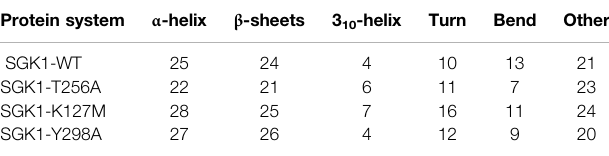
TABLE 2 | Percentage of amino acid residues participating in the secondary structure of SGK1-WT, SGK1-T256A, SGK1-K127M, and SGK1-Y298A. Protein system α -helix β -sheets 3 10 -helix Turn Bend Other